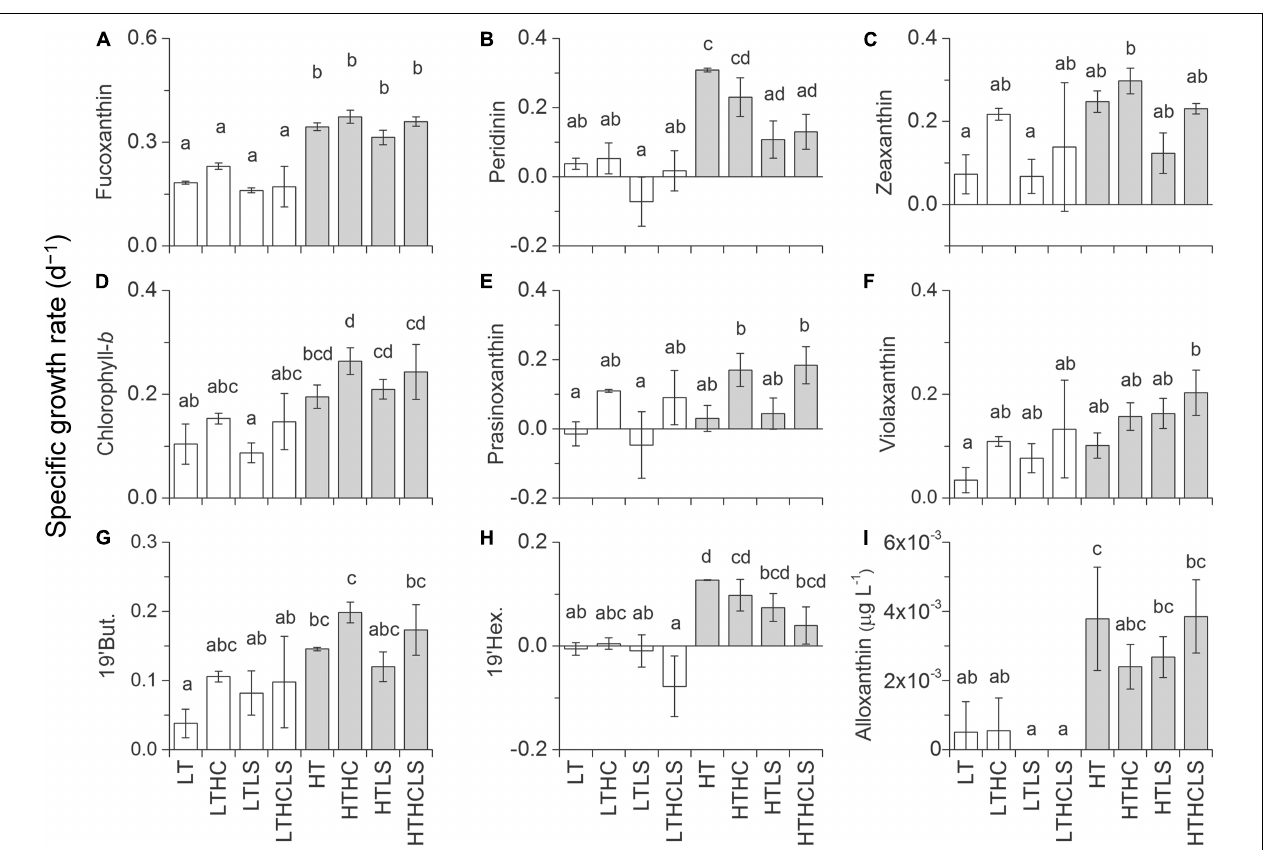
FIGURE 6 | The same figure style as that of Figure 5 but for the MR16-exp. except with (I) alloxanthin, which shows pigment concentration at the end of the culture (days 7 and 8 for the HT and LT series,